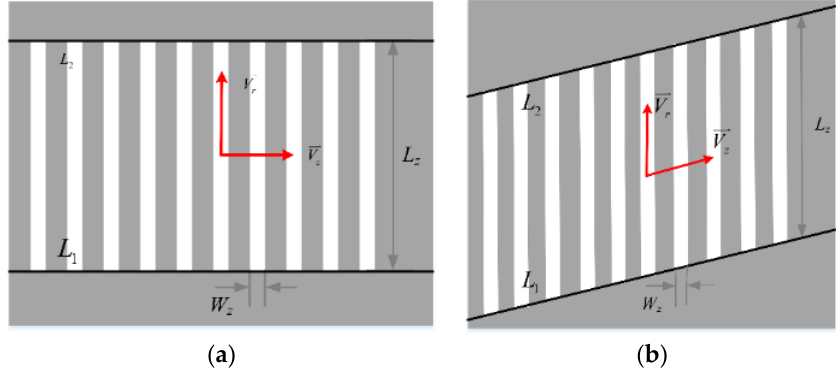
Figure 10. The model of zebra crossings: ( a ) the distribution direction is perpendicular to the road centreline; and ( b ) the distribution direction is oblique to the road centreline.